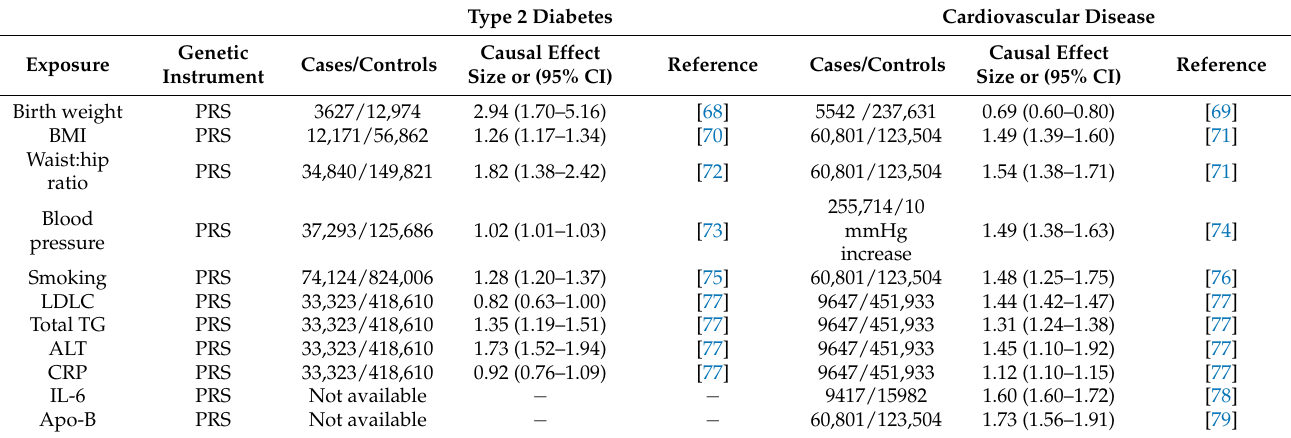
Table 1. Mendelian randomization studies on the risk factors for type 2 diabetes and cardiovascular disease. Type 2